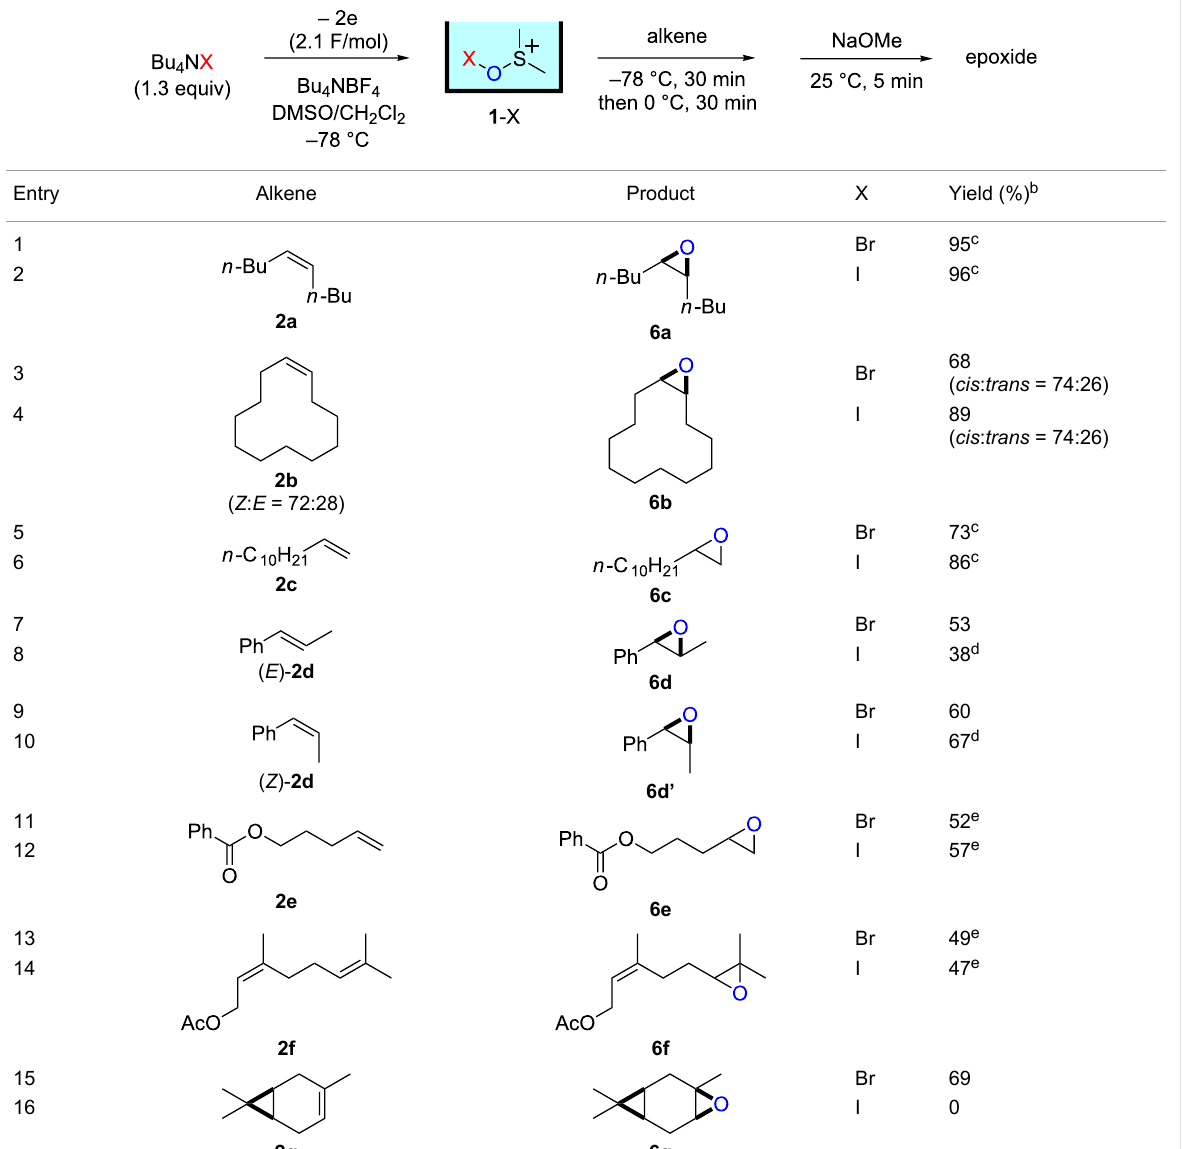
Table 3: Synthesis of epoxides by the reaction of 1 -X with alkenes followed by the treatment with NaOMe. a